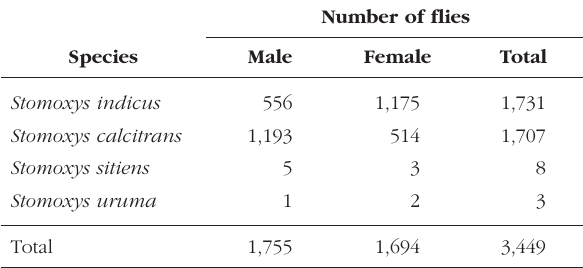
Table I. – Stomoxyine flies collected by Vavoua traps from a dairy cattle farm, Wang Nam Khiao District, Nakhon Ratchasima Province, Thailand (from January to December 2010).